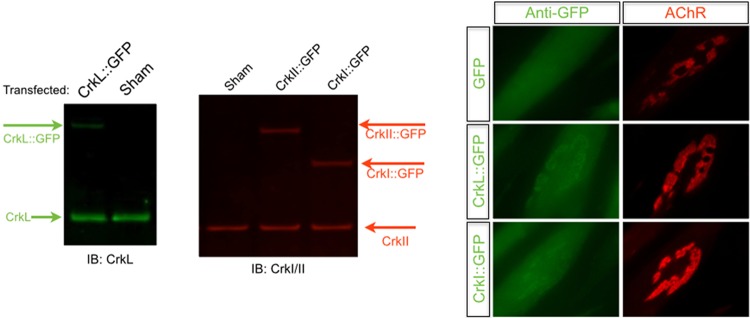
Exogenous Crk and CrkL are both enriched within AChR aggregates. In vitro-transcribed mRNAs encoding CrkL or both isoforms of the Crk gene, CrkI and CrkII, were fused to GFP and transfected into differentiated C2C12 myotubes. We analyzed soluble cellular lysates at 12 h posttransfection and confirmed the predicted sizes of our GFP fusion proteins by LiCor Odyssey infrared imaging using antibodies specific for CrkL or Crk. In parallel experiments, myotubes plated on laminin-111 were stained with fluorophore-conjugated bungarotoxin to label AChRs as well as Alexa Fluor 488-conjugated antibodies directed against GFP. Significant enrichment of CrkL-GFP, CrkI-GFP, and CrkII-GFP was observed within the area occupied by clustered AChRs and to a lesser degree the gaps within AChR clusters.